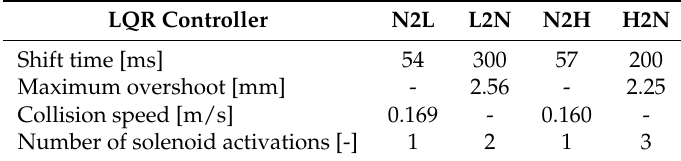
Table 3. Performances of the LQR controller at 9 bar supply pressure